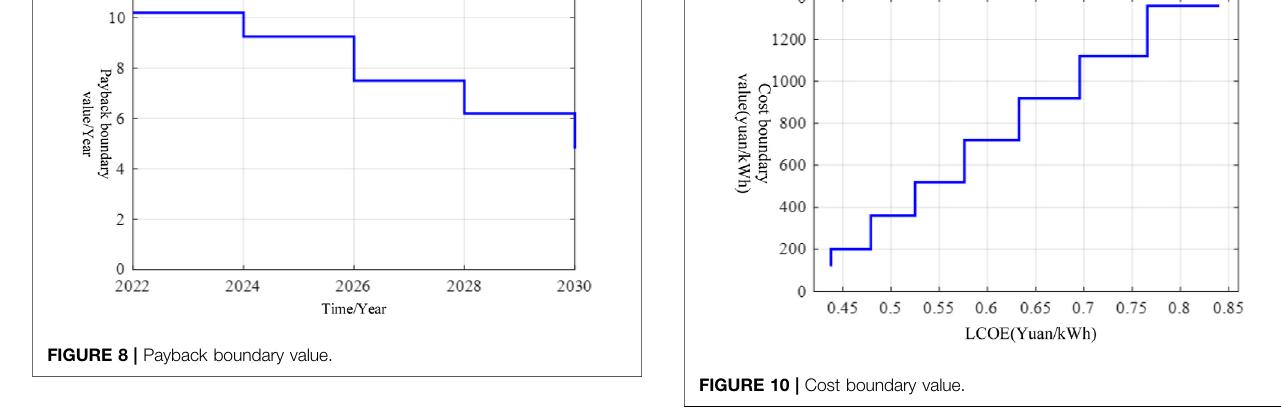
FIGURE 10 | Cost boundary